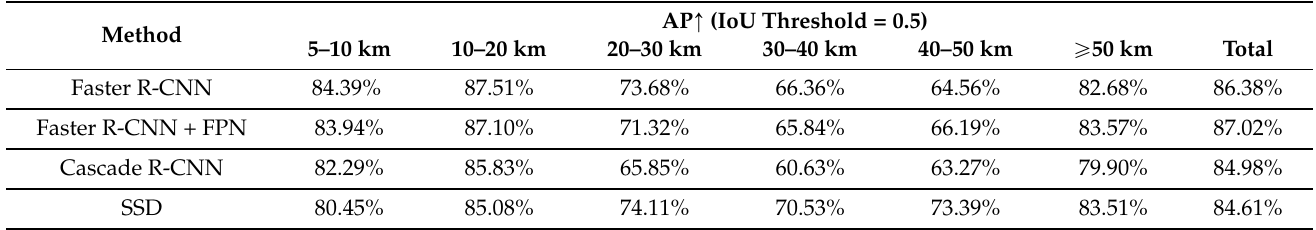
Figure 8. Variation of Average precision (AP) for nine CNN models on different diameter groups of the test set with the number of the ground-truth (GT) craters on the training set. Table 2. Average precision (AP) of nine CNN models on different diameter groups of the test